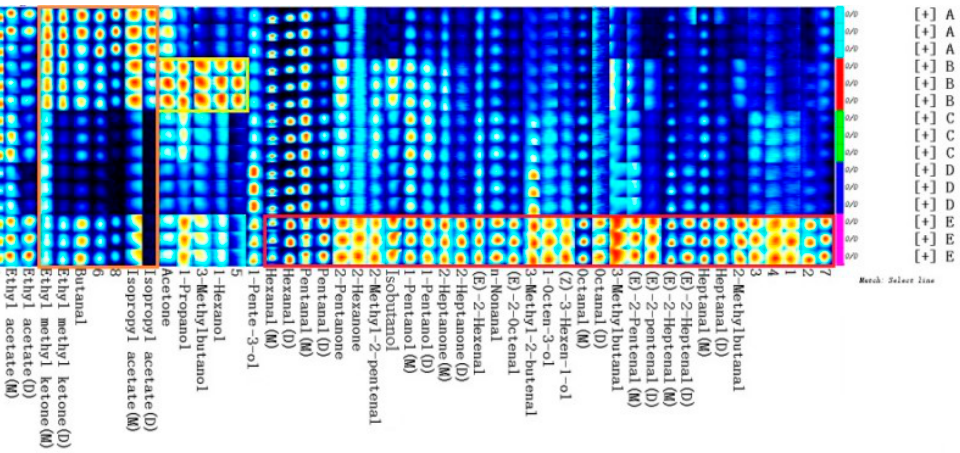
Figure 2. Fingerprint (gallery plot) of characteristic VOCs in walnut oil from five different varieties